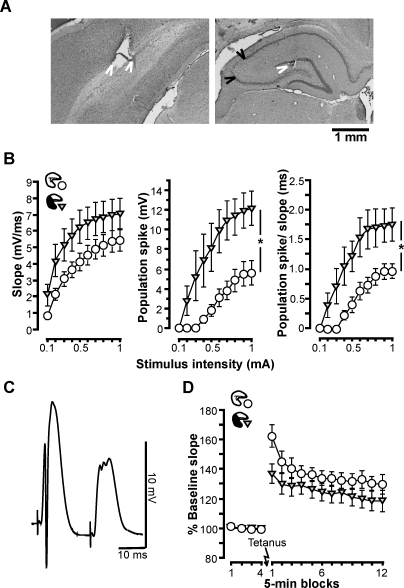
Experiment 3: Functional and Plastic Entorhinal Cortex–Dentate Gyrus Connectivity in Hippocampal Residuals at the Septal Pole(A) Electrolytic lesions (white arrowheads) marking the stimulation site in the perforant path (bipolar electrode, left) and the recording site in the ipsilateral dentate gyrus in cresyl-violet–stained coronal sections. Photos are from a brain with partial hippocampal lesion sparing the septal pole (35% of hippocampal volume), and damage to CA3 (black arrowheads) is visible at the level of the recording site.(B) Input–output curves recorded from rats with sham lesions or with partial hippocampal lesions sparing residuals at the septal pole: different measures of the evoked field response (mean ± SEM) are plotted as function of the stimulus intensity (0.1–1 mA). An asterisk (*) indicates significant main effect of group (p < 0.03).(C) Paired-pulse inhibition in a septal hippocampal residual: field responses evoked by paired stimulation (0.5 mA, 20 ms apart; average of 15 samples). Note the large population spike in the first response and its virtual absence in the second response. The residual hippocampal volume in this case was 27%.(D) Brief tetanic stimulation induces similar LTP of the evoked response in rats with sham lesions and with partial hippocampal lesions sparing residuals at the septal pole. The evoked response is expressed as percentage baseline slope (mean ± SEM).